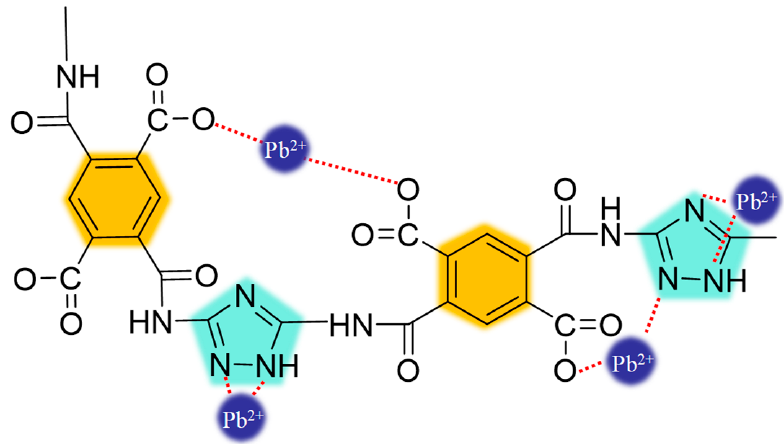
Figure 5. ( A ) FTIR spectra, ( B ) XPS survey and high resolution XPS spectra of ( C ) N1s and ( D ) O1s of PAA sponge after adsorption of Pb(II).